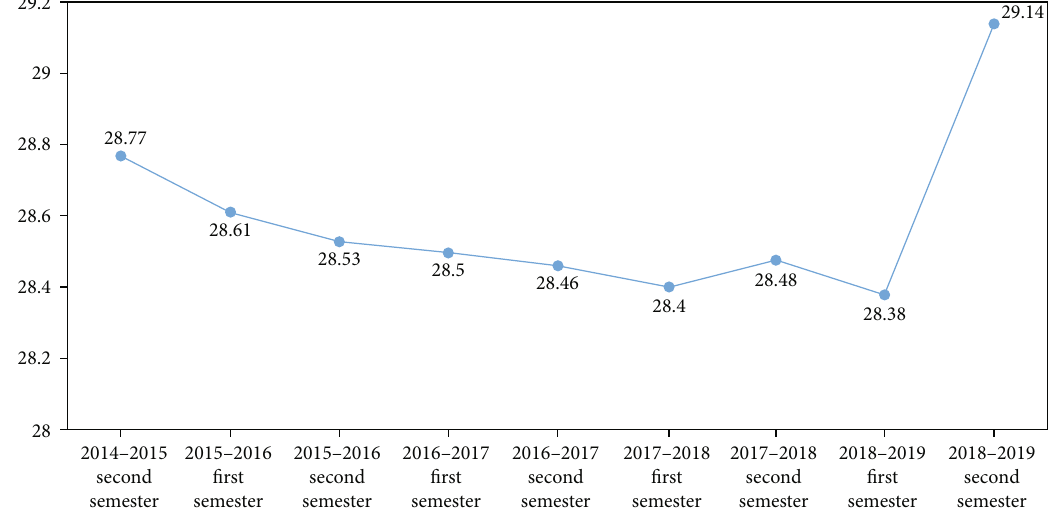
Figure 8: The percentage of category 2 teachers in school Y over the past fi ve years.